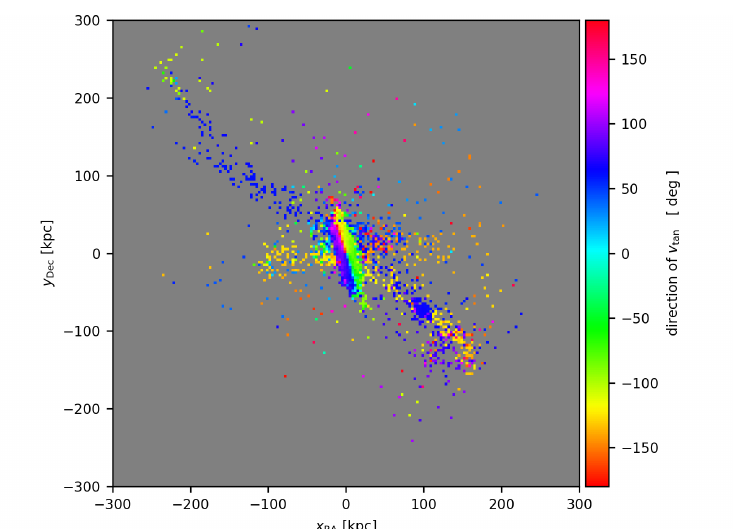
Figure 4. The same as in Figure 3 but the direction of the proper motion is shown. The direction is measured counter clockwise from the positive x